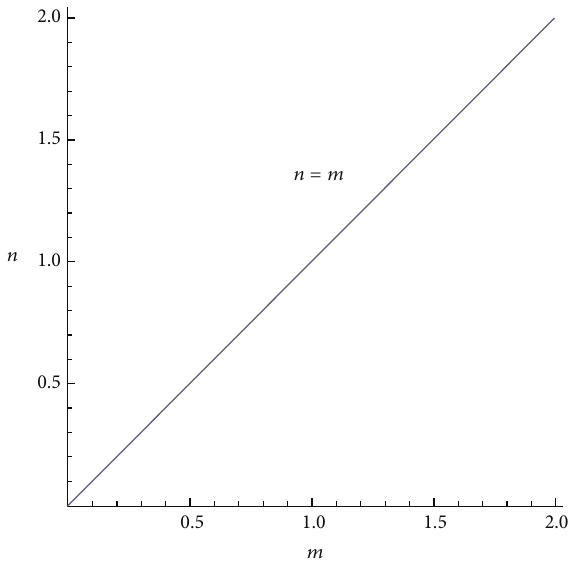
Figure 2: The (𝑚,𝑛) -plane. The special cases lie on the line 𝑛 = 𝑚 . and the conserved vector (111). We find that (135) is associated with (111) provided that 𝑐 3 = 0 , that is, provided that